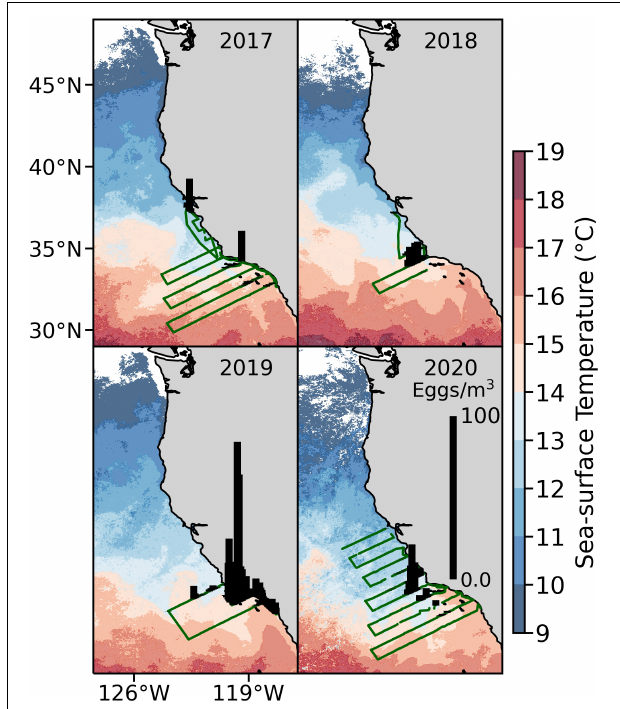
FIGURE 11 | Densities of anchovy eggs (black bars) captured in the Continuous Underway Fish Egg Sampler during winter CalCOFI cruises, 2017–2020. Green lines indicate the ship’s positions during sampling. Data were overlaid on satellite-derived sea surface temperatures (AVHRR 1.4-km